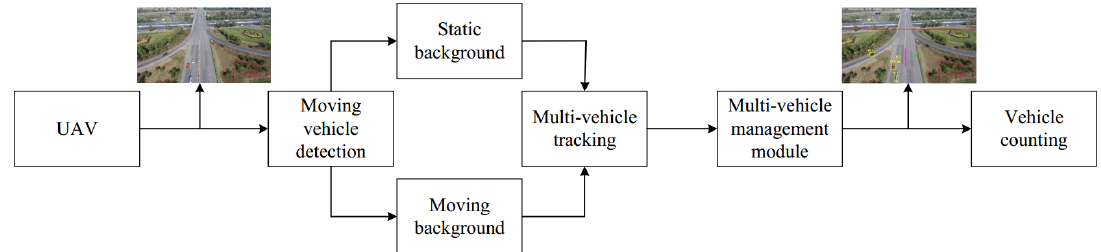
Figure 1. Framework of the proposed method. It consists of vehicle detection, multi-vehicle tracking, multi-vehicle management, and vehicle counting. The UAV is equipped with a visual sensor. Vehicles are detected by the detector which can handle two situations: static background and moving background. Then, the detected vehicles are tracked by tracking module. By analyzing the results of the tracker, we can count the number of